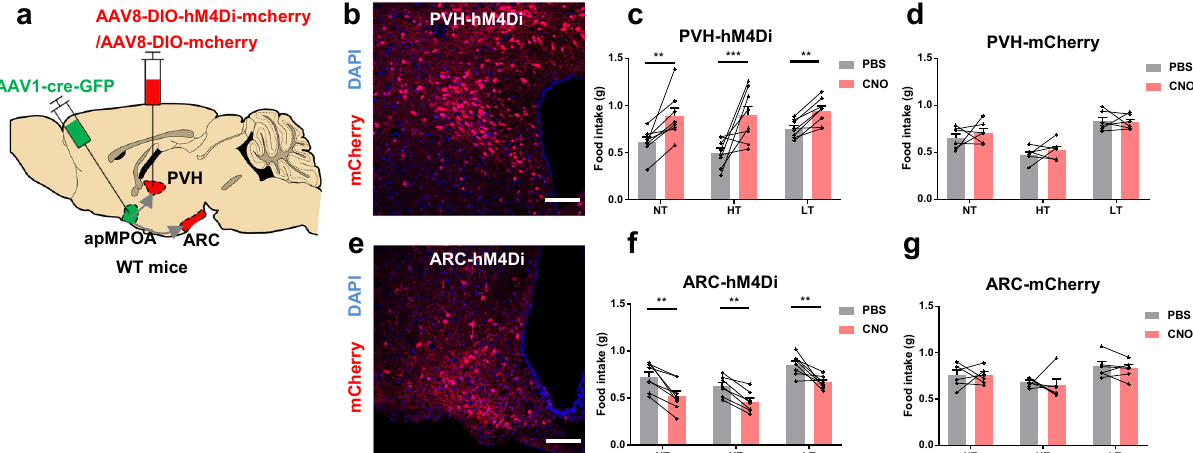
Fig. 5 Feeding behavior after chemogenetic inhibition on the apMPOA-recipient neurons in ARC/PVH. a Chemogenetic inhibiting apMPOA-recipient neurons in ARC/PVH individually in wild type mice by injecting AAV1-Cre-GFP in apMPOA and DREAD-Gi in the ARC and PVH. Transsynaptic neurons in the PVH ( b ) and ARC ( e ) expressed hM4Di-mCherry. Image representative of n = 8 mice. Scale bar, 100 µ m. c Chemogenetic inhibiting postsynaptic PVH neurons signi fi cantly increased food intake after CNO injection under all thermal conditions compared to PBS. Interaction effect: F 2,13 (temperature